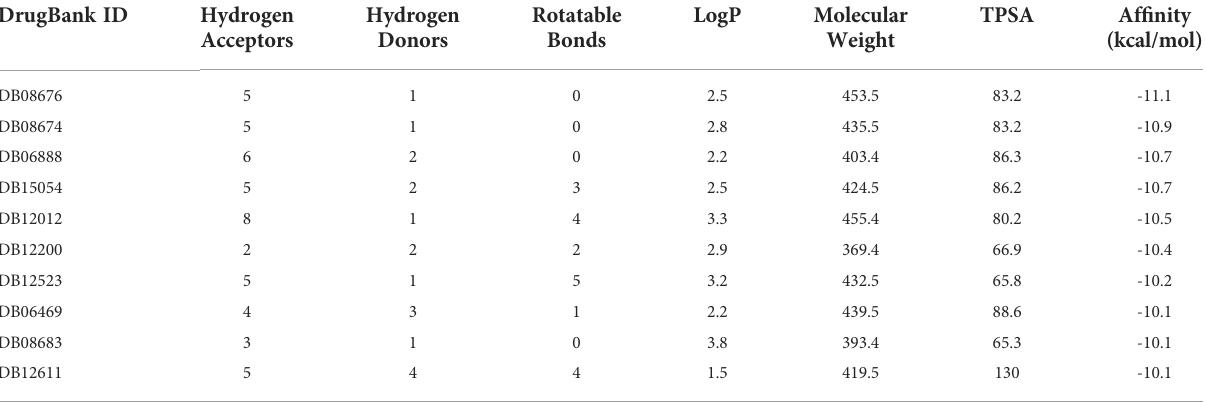
TABLE 1 Top 10 compounds with the best docking scores with PAK7.